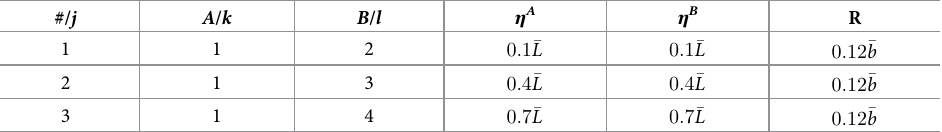
Table 2. Transversal vessels V j , j = 1, 2, 3 of the vertex vein vasculature. The structure is generated by three vessels, see Eq (4). #/